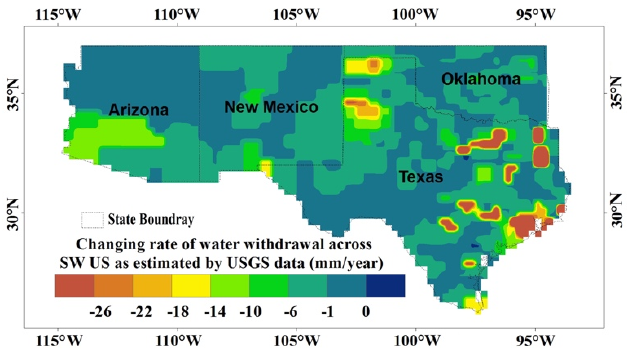
Figure 3. Changing rate of water withdrawal for human society from 2003 to 2010.